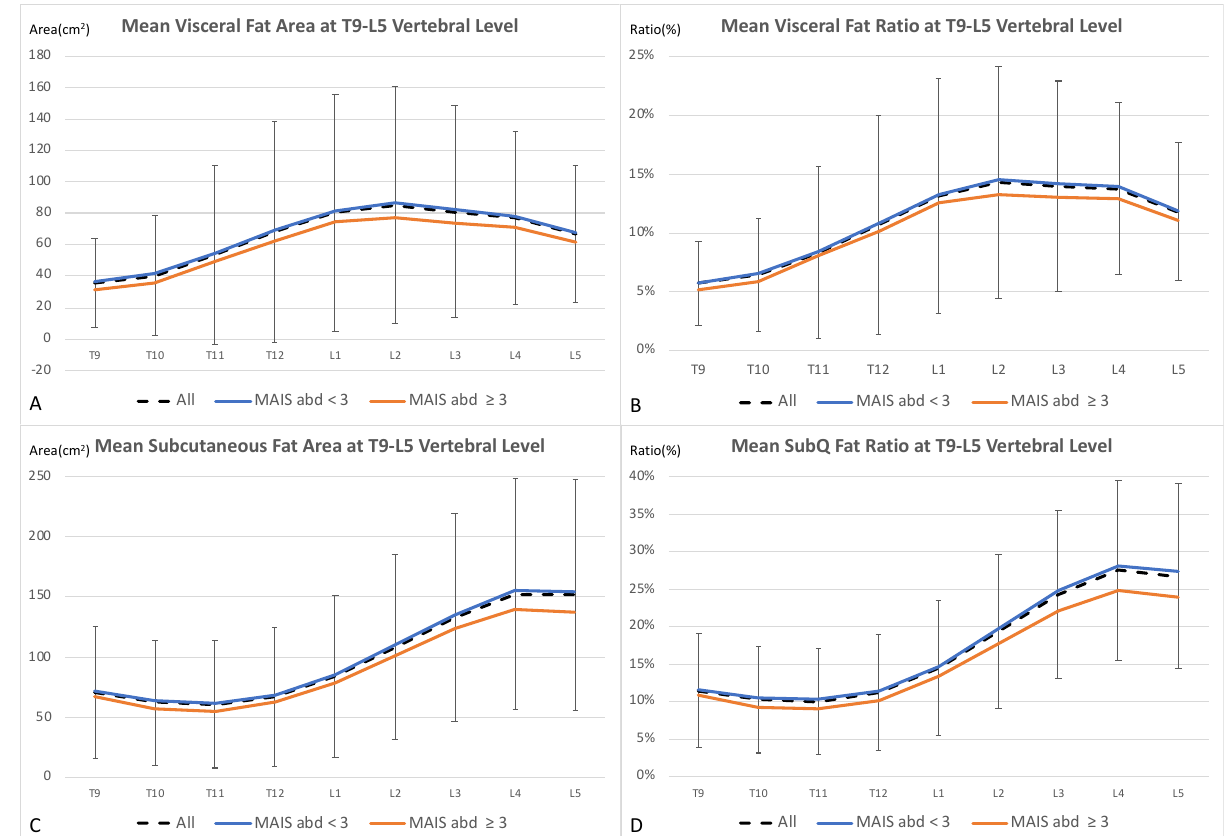
Figure 2. ( A – D ). Mean visceral fat area ( A ) and subcutaneous fat area ( C ) from the T9-L5 vertebral level are shown. The visceral fat ratio ( B ) and subQ fat ratio ( D ) were obtained. The standard deviation of all VRUs was represented in black error bars. While visceral fat area and ratio peaked at the L2 level, subcutaneous fat area and ratio peaked at the L4 level. Vulnerable road users with serious abdominal injury (MAIS abd ≥ 3, represented in blue lines) had lower fat areas and ratios than those with minor injury (MAIS abd < 3, brown lines).